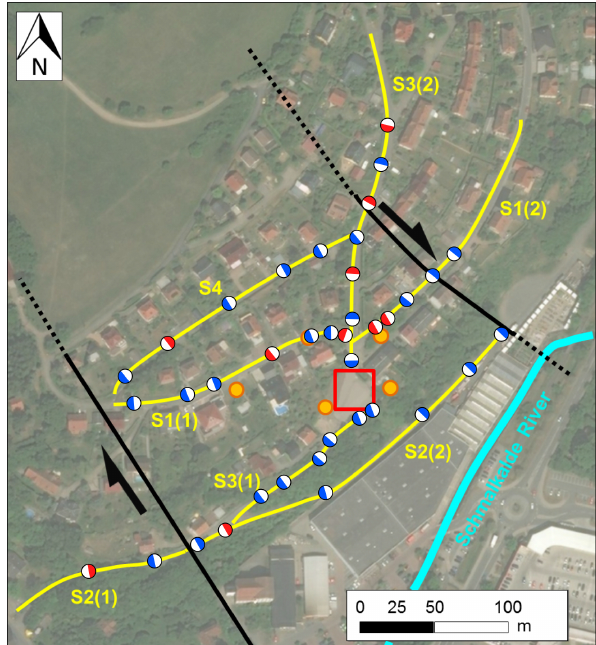
Figure 10. Map showing the complex fault geometry around the sinkhole. The faults identified in the S H -wave seismic profile were extrapolated to the surface. Blue and red balls represent normal and reverse faults, respectively. The white areas within the balls display the position of the hanging wall. Note the high fault density north of the sinkhole area with fault blocks less than 10m wide. For borehole information (orange dots), refer to Fig. 3.